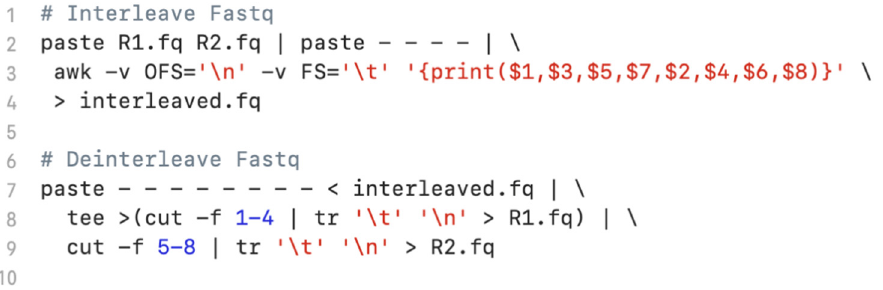
Figure 3. Bash script commonly used to interleave and deinterleave FASTQ files. At line 2 the command used to interleave two FASTQ files; at line 7 the command used to deinterleave a FASTQ file. SeqFu was two times faster than Bash for interleaving, taking 4.7 ± 0.14 s